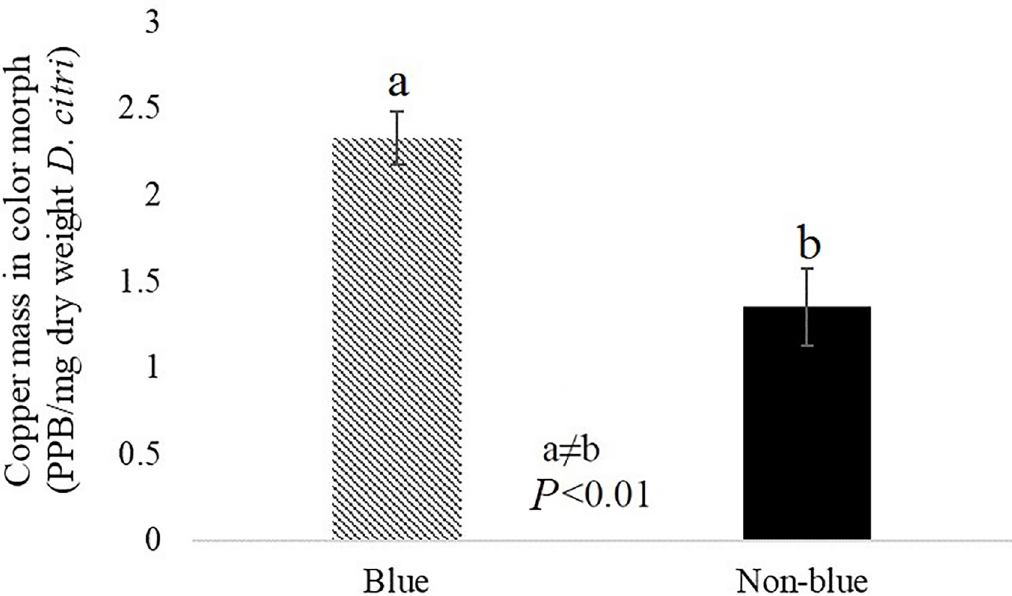
Fig 6. Comparison of copper mass between color morph D . citri adults using ICP mass